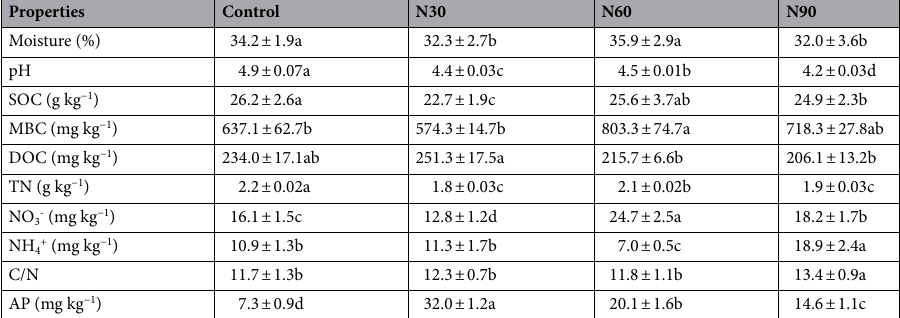
Table 1. Average physicochemical properties of the soil in the Moso bamboo forest study plots. SOC soil organic carbon, MBC microbial biomass carbon, DOC dissolved organic carbon, TN total nitrogen, NO 3− nitrate, NH 4+ ammonium, C/N carbon/nitrogen, AP available phosphorous. Mean ± SD (n = 3). Different lower- case letters indicate significant differences at P < 0.05 for all treatments.